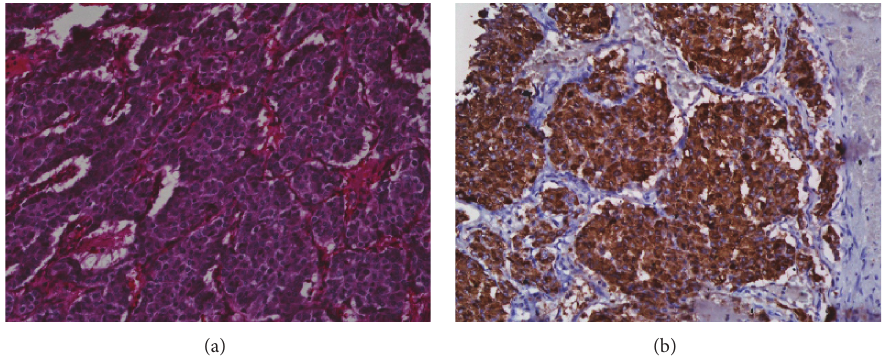
Figure 4: Microscopic images of pheochromocytoma. (a) Routine hematoxylin and eosin (H&E) staining at low magnification (20x) highlights the typical “Zellballen” growth pattern characterized by nests of tumor cells surrounded by delicate fibrovascular stroma. (b) Immunohistochemistry for the neuroendocrine marker chromogranin A shows strong, diffuse staining in the tumor